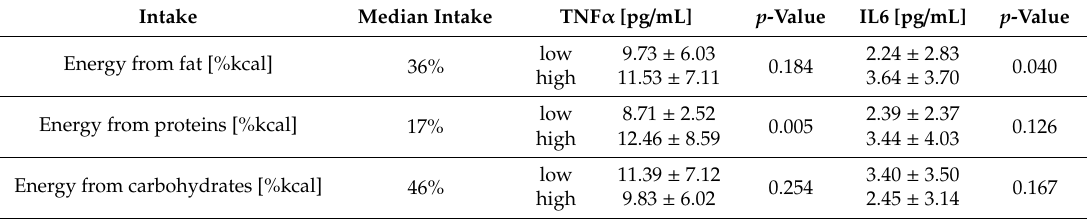
Table 3. E ff ect of initial nutrient intake on baseline blood cytokine